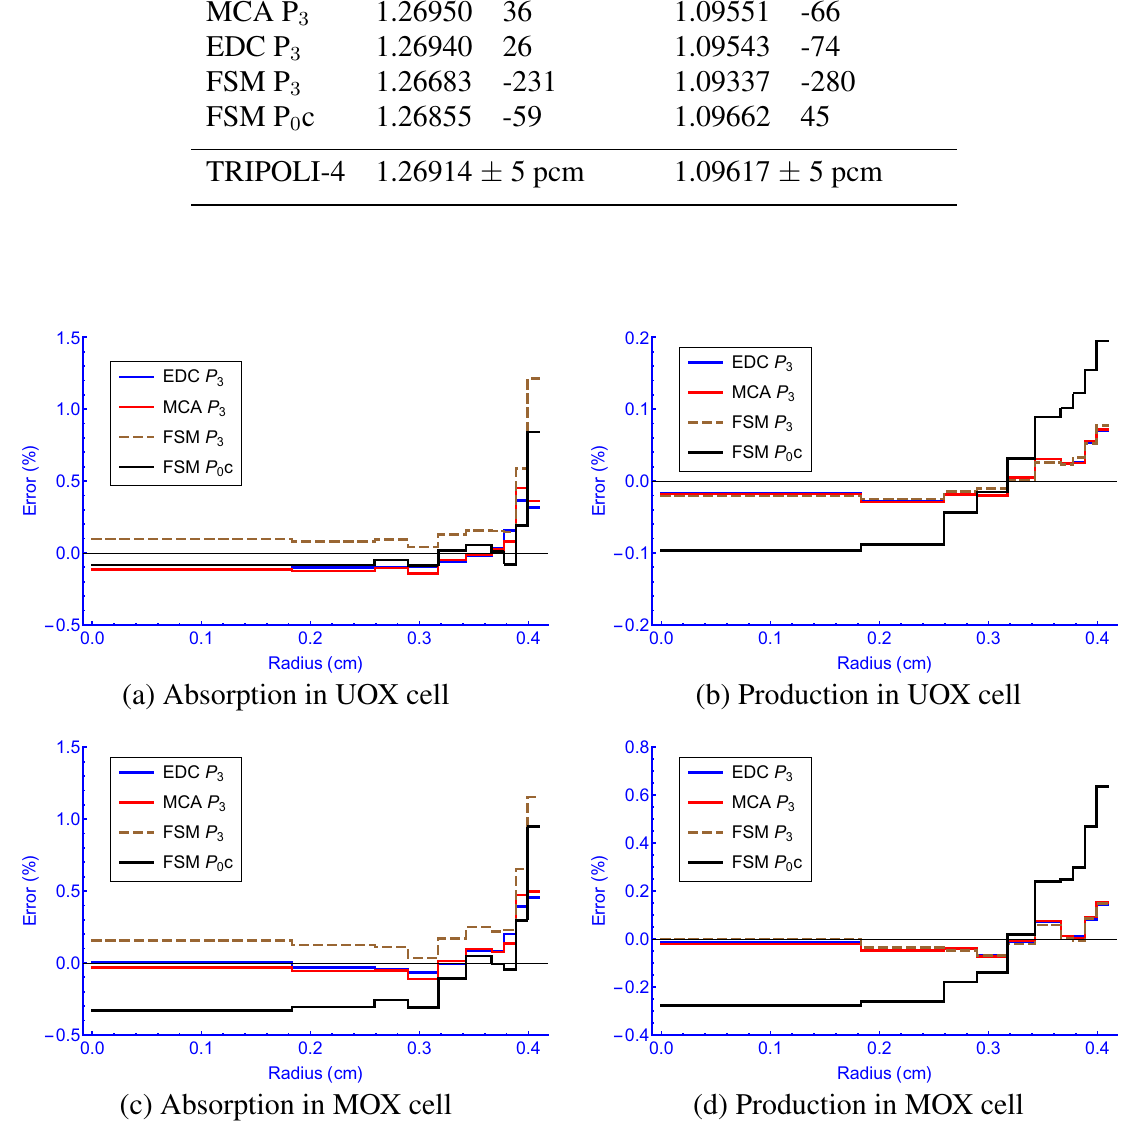
Figure 1: The per-ring reaction rate errors in fuel